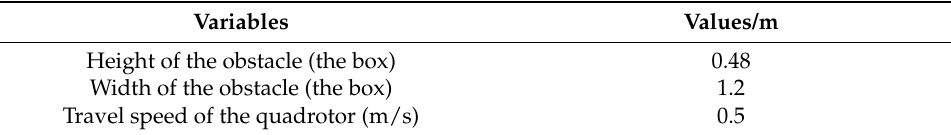
Figure 10. Terrain-following experiment of the quadrotor above the ground with the cardboard box as the obstacle or the ground undulation. Table 5. Variable setting of the experiment.